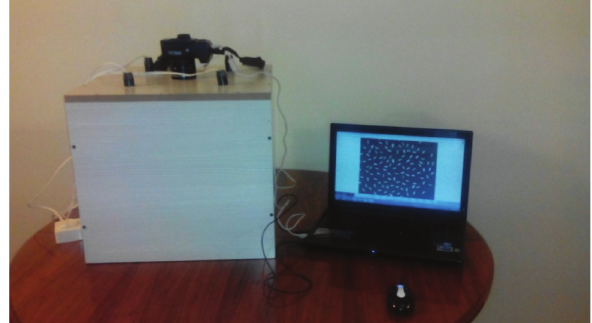
Figure 1: Hardware System of Machine Vision